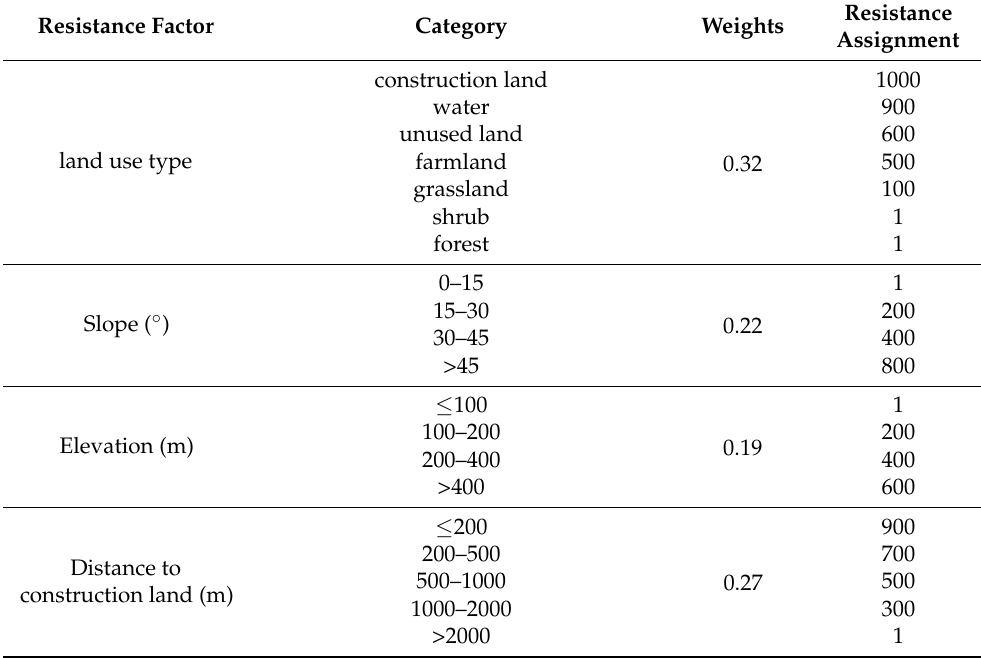
Table 2. Resistance factor assignment and